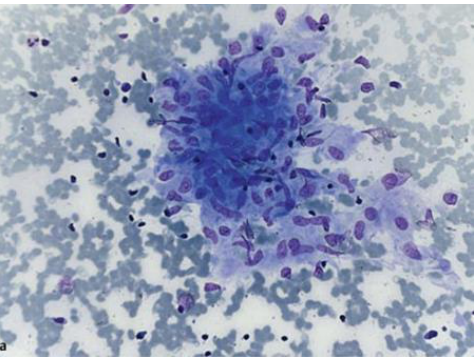
Figure 2. Cytological sample showing loosely aggregated epithelioid cells without necrosis, stained in Diff Quick for rapid on-site evaluation. Courtesy of von Bartheld et al. [37] who own the